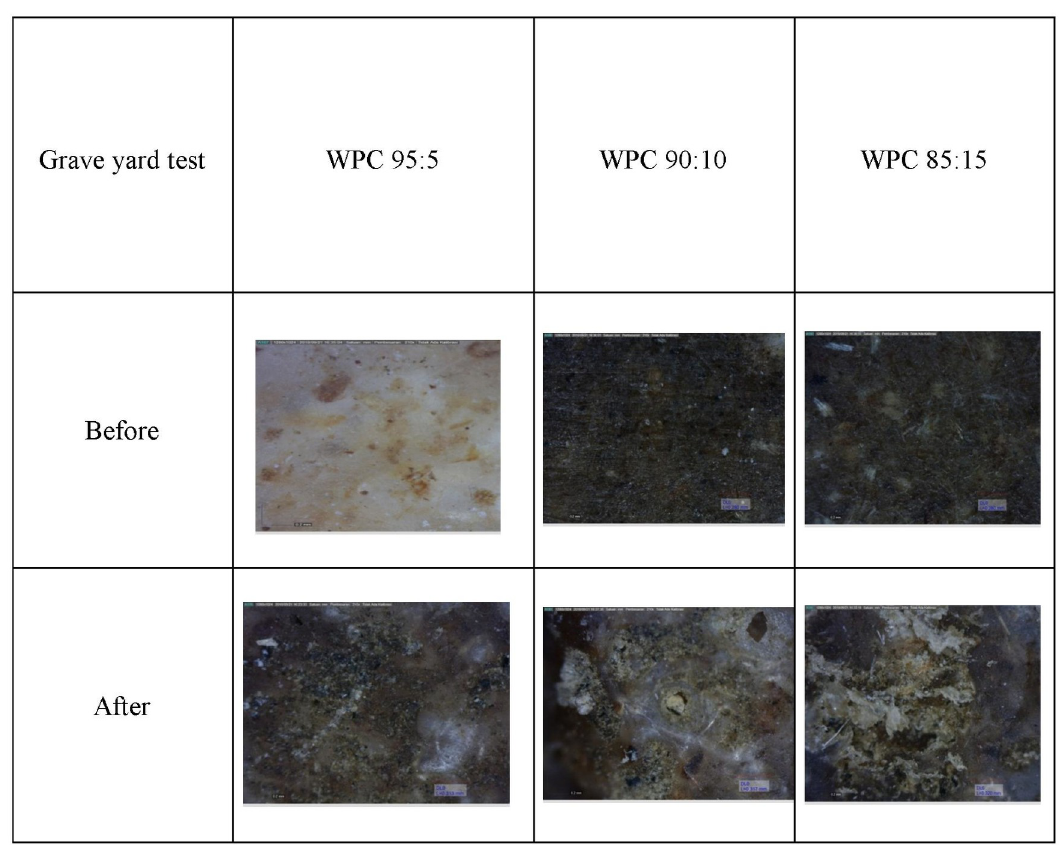
Fig 9. Color performance of WPCs in various ratios of LDPE and wood filler.